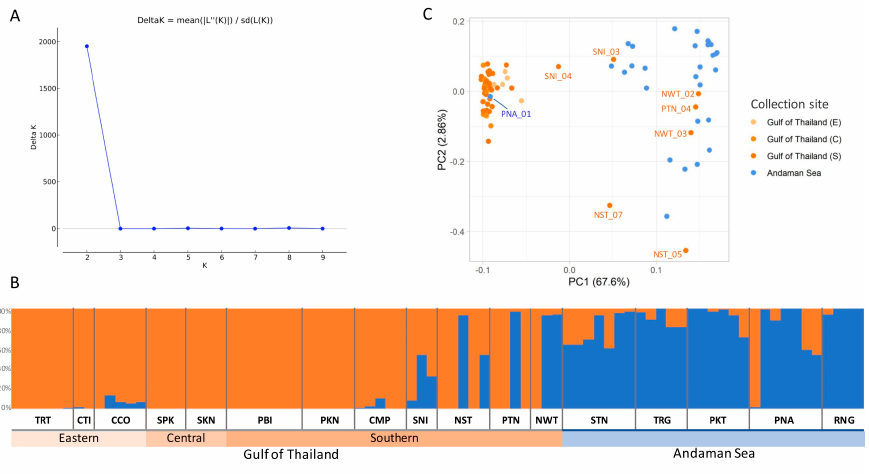
Figure 4. Clustering results of 82 R. apiculata accessions. ( A ) The mean estimated delta K values for different numbers of populations assumed K ranging from 1 to 10 in the STRUCTURE analysis. ( B ) Structure plot of R. apiculata individuals for K = 2. Each vertical bar represents an individual. The analysis shows two genetic clusters of R. apiculata on the Gulf of Thailand and the Andaman Sea coasts. Group 1: TRT-CTI-CCO-SPK-SKN-PBI-PKN-CMP-SNI-NST-PTN-NWT and Group 2: STN-TRG-PKT-PNA-RNG. ( C ) PCA of 82 R. apiculata accessions. Each point represents a single individual. Different colors denote four collection sites, which are light orange for the eastern Gulf of Thailand (E), orange for the central Gulf of Thailand (C), dark orange for the southern Gulf of Thailand (S), and blue for the Andaman Sea. The percent of PC1 and PC2 are identified by the x -axis and y -axis, respectively.